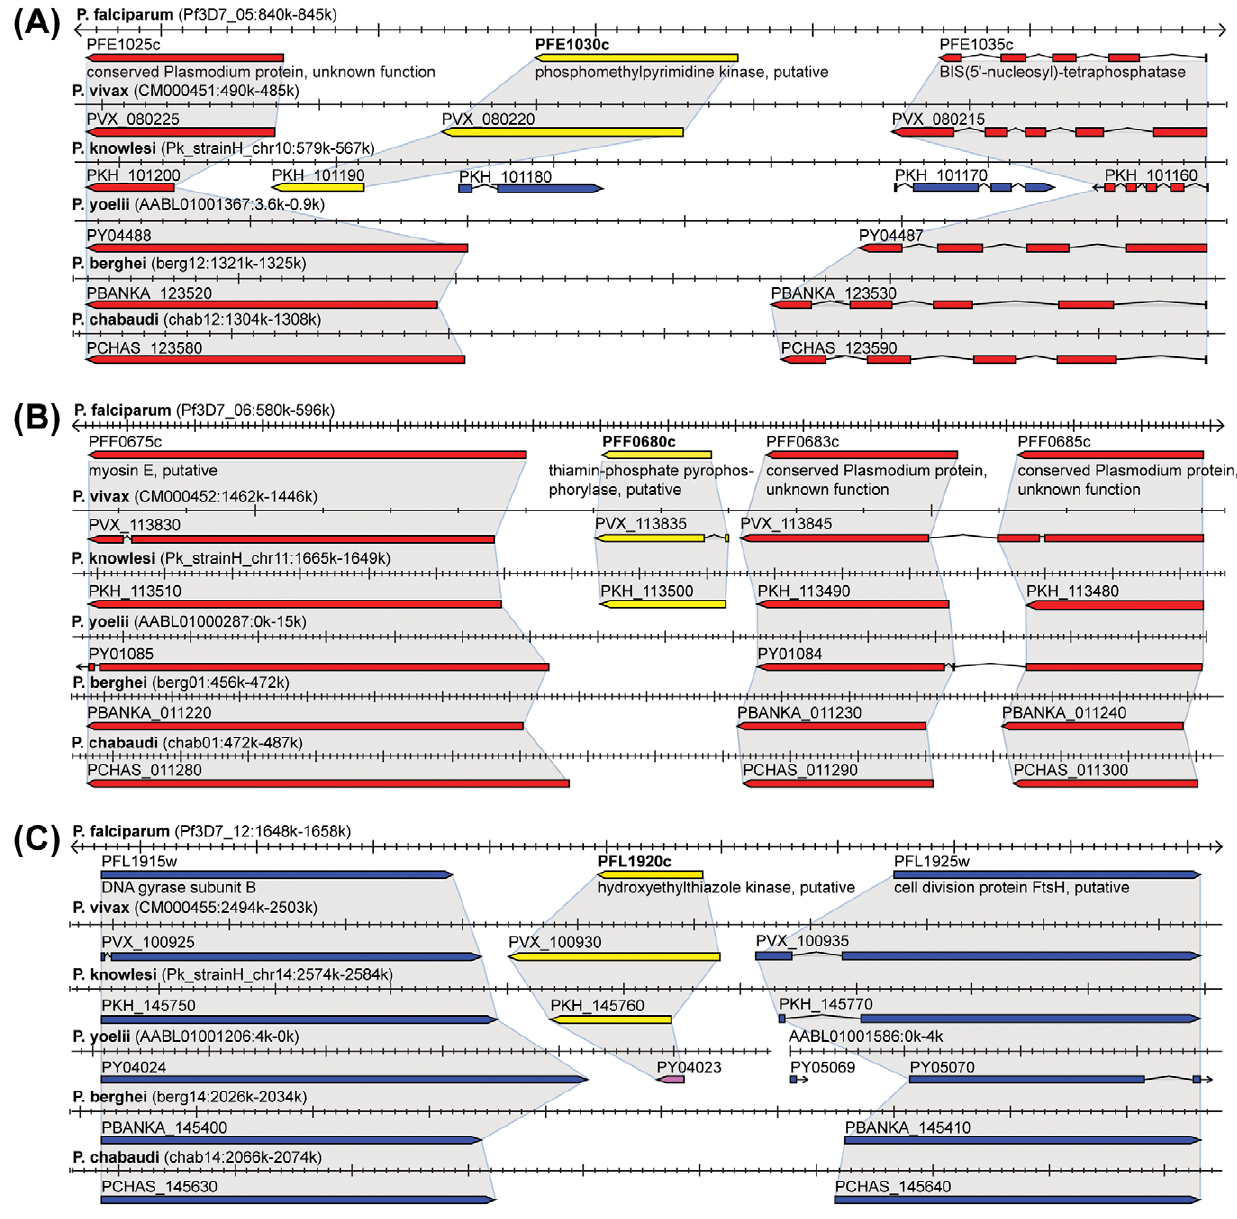
Figure 3. Syntenic orthologs of thiamine biosynthesis genes present in primate but not rodent parasites. Each panel shows one of the three P. falciparum thiamine biosynthesis gene on top (gene identifier in bold) and syntenic genomic regions in P. vivax , P. knowlesi , P. yoelii , P. berghei , and P. chabaudi below. Shaded areas indicate orthology. Thiamine biosynthesis genes displayed in yellow. Flanking genes and their orthologs on forward and reverse strand are shown in blue and red, respectively. The three P. falciparum genes are located on three different chromosomes and in all three cases syntenic orthologs are present in primate but not rodent parasite genomes. The syntenic P. yoelii ortholog of PFL1920c (PY04023, Panel C) is an exception but appears to be a truncated gene relic that should be annotated as pseudogene. Orthologs of PFF0683c and PFF0685c (Panel B) are merged into single genes in P. vivax and P. yoelii and should be split. Images adapted from PlasmoDB 8.0.